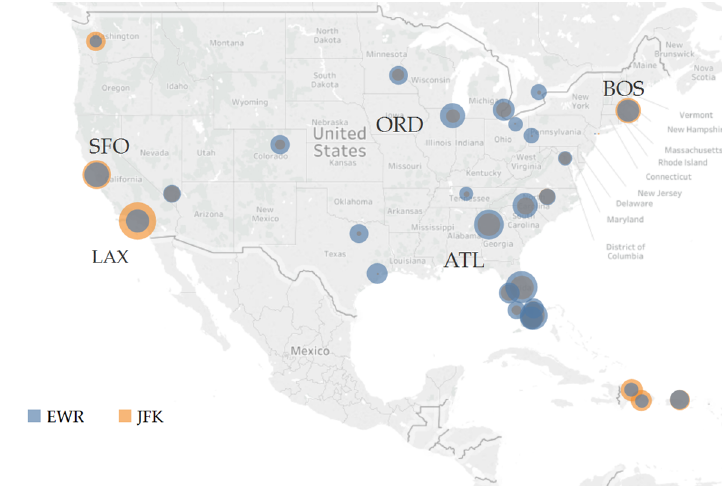
Figure 11. Top 30 airports based on number of flights connecting with EWR/JFK.